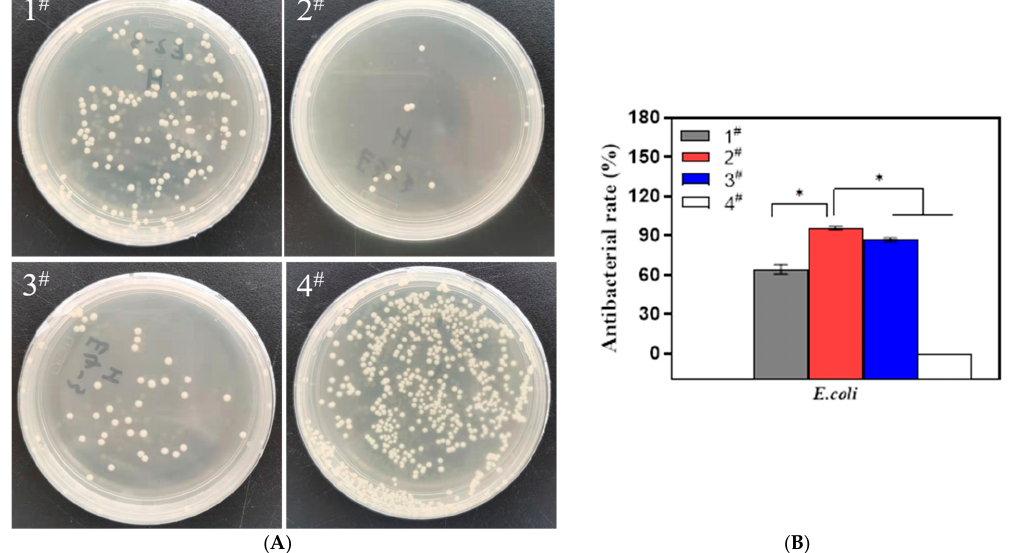
Figure 7. ( A ) Bacterial colonies on Ti-40Nb-10Ag for different sintering temperature (1 # , 2 # , 3 # ) and Ti-40Nb alloy (control group-4 # ); ( B ) Antibacterial rate of Ti-40Nb-10Ag for different sintering tem- perature (1 # , 2 # , 3 # ) and Ti-40Nb alloy (control group-4 # ). Error bars represent mean ± SD for n = 3, * p < 0.01.